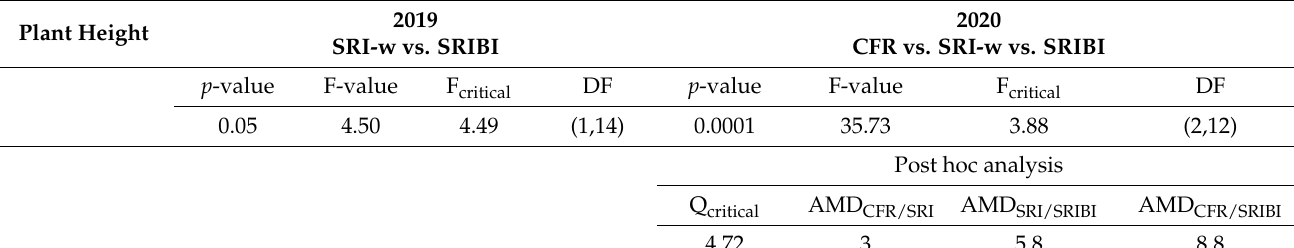
Table 5. Parameters from ANOVA statistical analysis for plant height